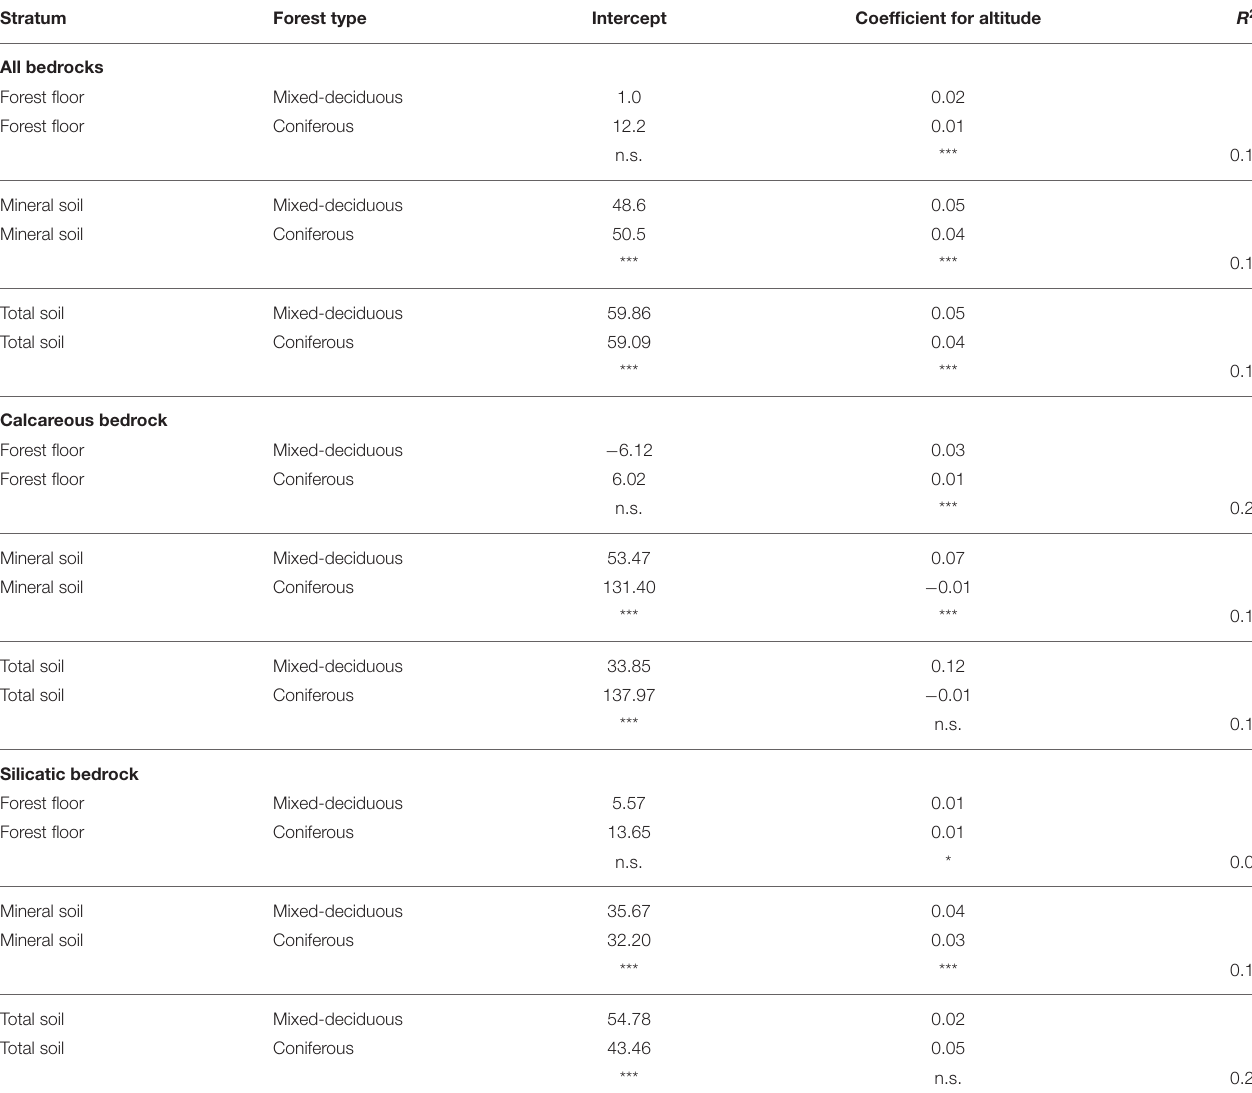
TABLE 3 | Linear regression functions for the estimation of the soil carbon stock in different strata, as obtained by a covariance analysis with elevation as continuous and bedrock type as categorical variable.